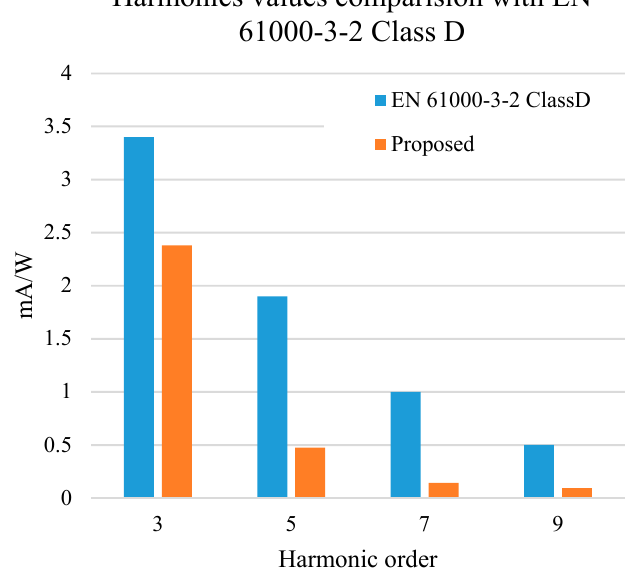
Figure 16. Comparison between the proposed Input current values and maximum level for EN 61000-3-2 Class D standard.